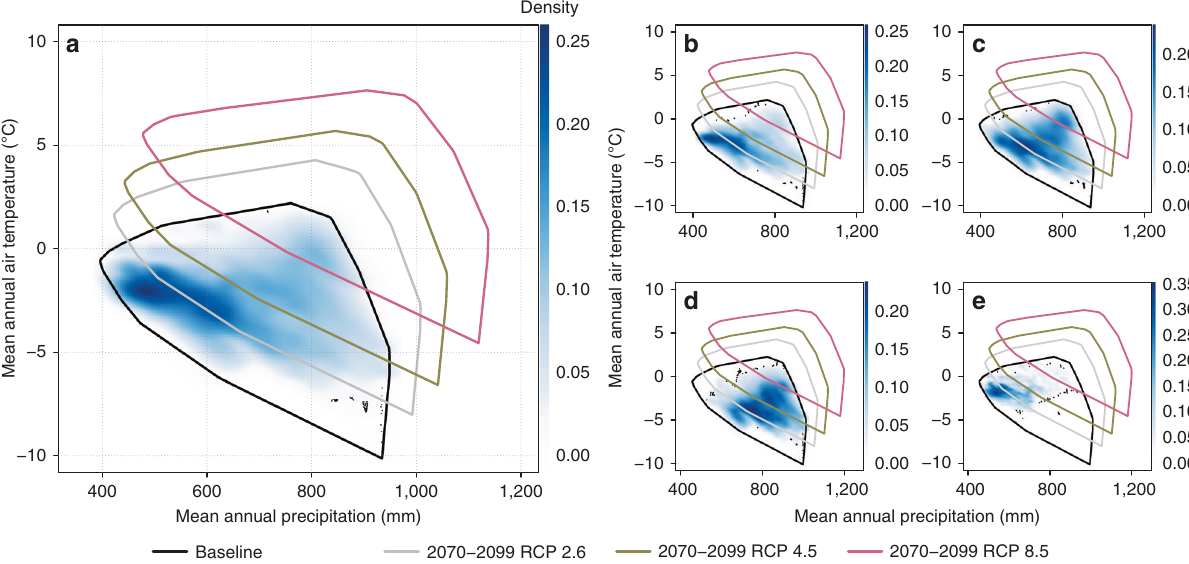
Fig. 3 The dwindling periglacial climate. The density scatterplots represent the modelled occurrence of the LSP ( blue shades ; combined spatial extent of individual LSPs in the large plot, a ) compared to baseline (climate of 1981 – 2010) mean annual air temperature and mean annual precipitation in the study area. The black dots indicate individual modelled LSP occurrences ( b cryoturbation, c geli fl uction, d nivation and e permafrost mounding) based on empirical data with total of 2,917 observations. The polygons depict the convex hulls (i.e., the minimum bounding boxes) of the two climate variables in the study area, and at four time periods and/or climate change scenarios, indicating the shift in climatic conditions in respect to the current periglacial climate realm of the study